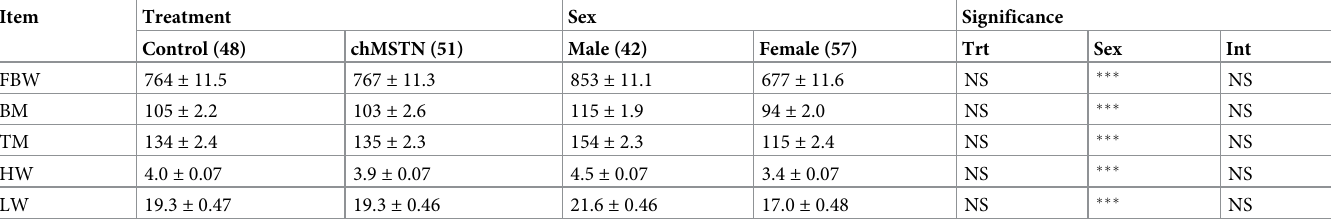
Table 2. Carcass characteristics of chicks from the Control and chMSTN groups in Experiment 1.